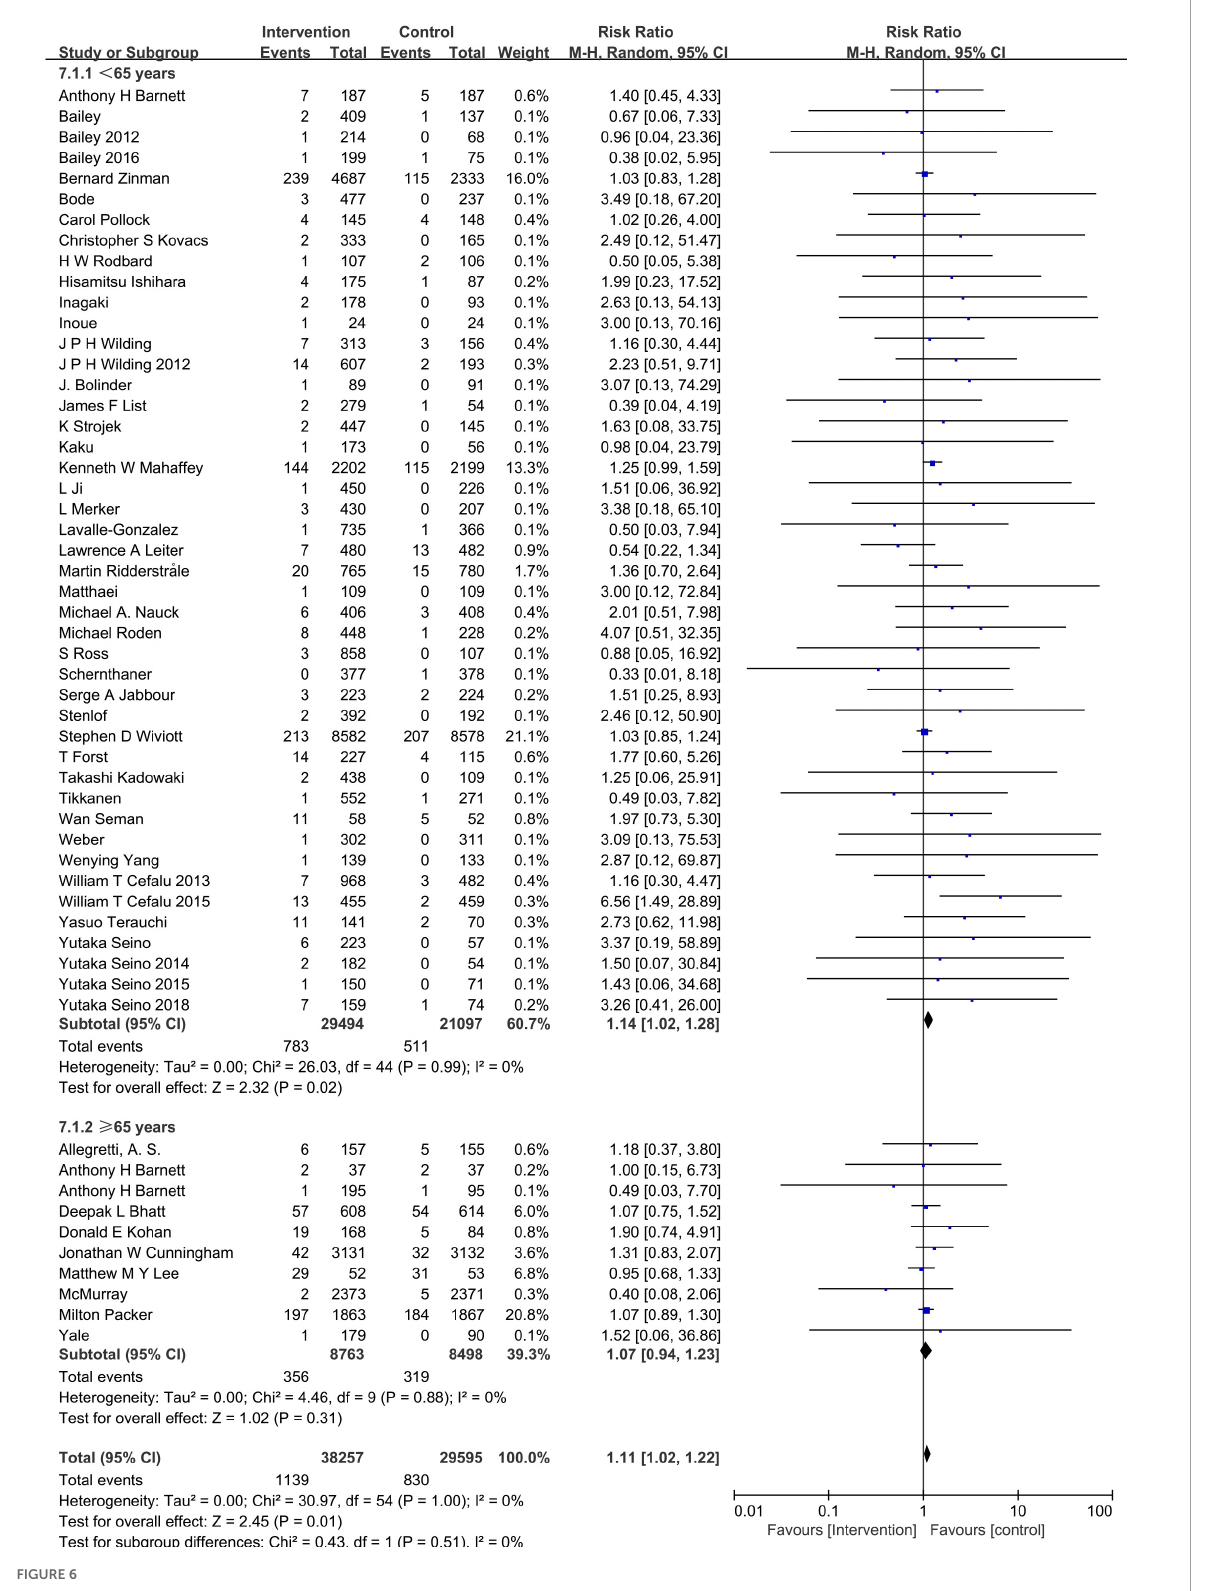
FIGURE6 Subgroup analysis of the hypovolemia events between the SGLT2 inhibitors group vs. the placebo group stratified by